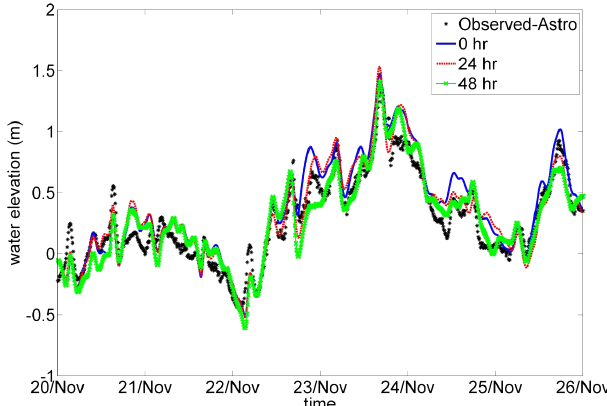
Figure 12. Surge elevation for IJmuiden during the November 2009 storm: blue – analyzed HIRLAM; red – 24h HIRLAM; green – 48h HIRLAM; black dots – observation.